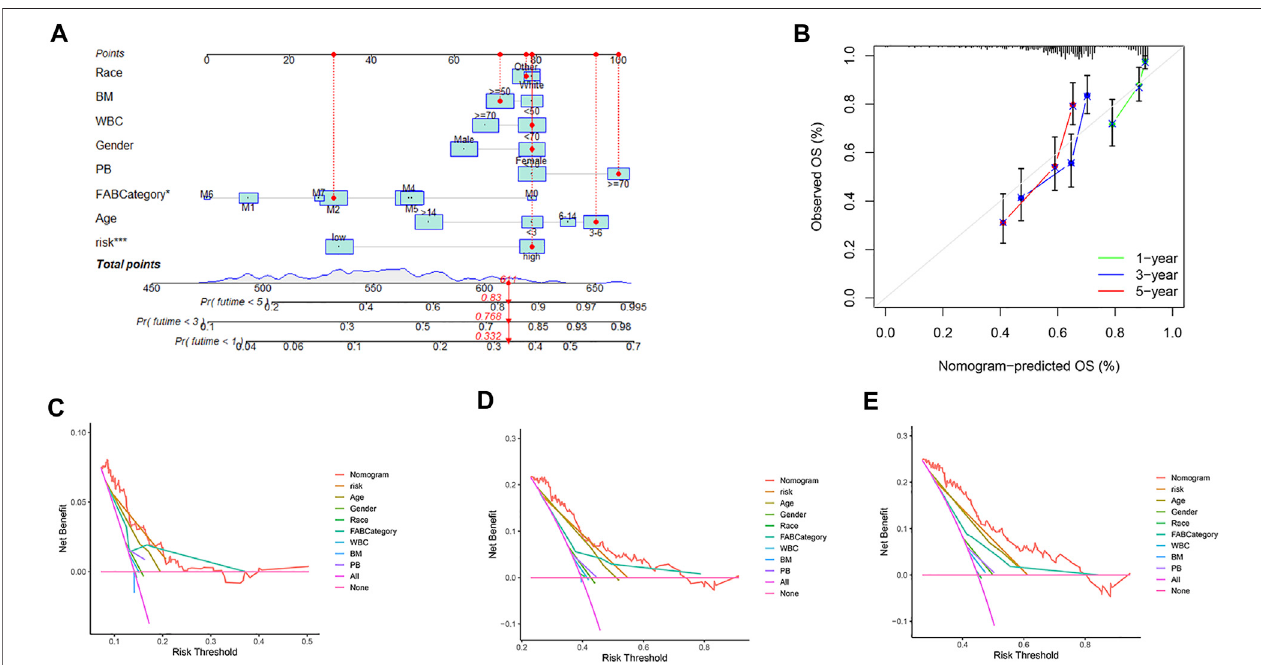
FIGURE 8 | Decision curves and nomograms were included for all factors. (A) Nomogram with gender, race, BM, PB, WBC, age, FAB categories, and risk. (B) Calibration curves for 1-, 3-, and 5-years. (C) Decision curve at one year (D) Decision curve at three years. (E) Decision curve at fi ve years. Bone marrow leukemic blast percentage (%) (BM), peripheral blasts (%)